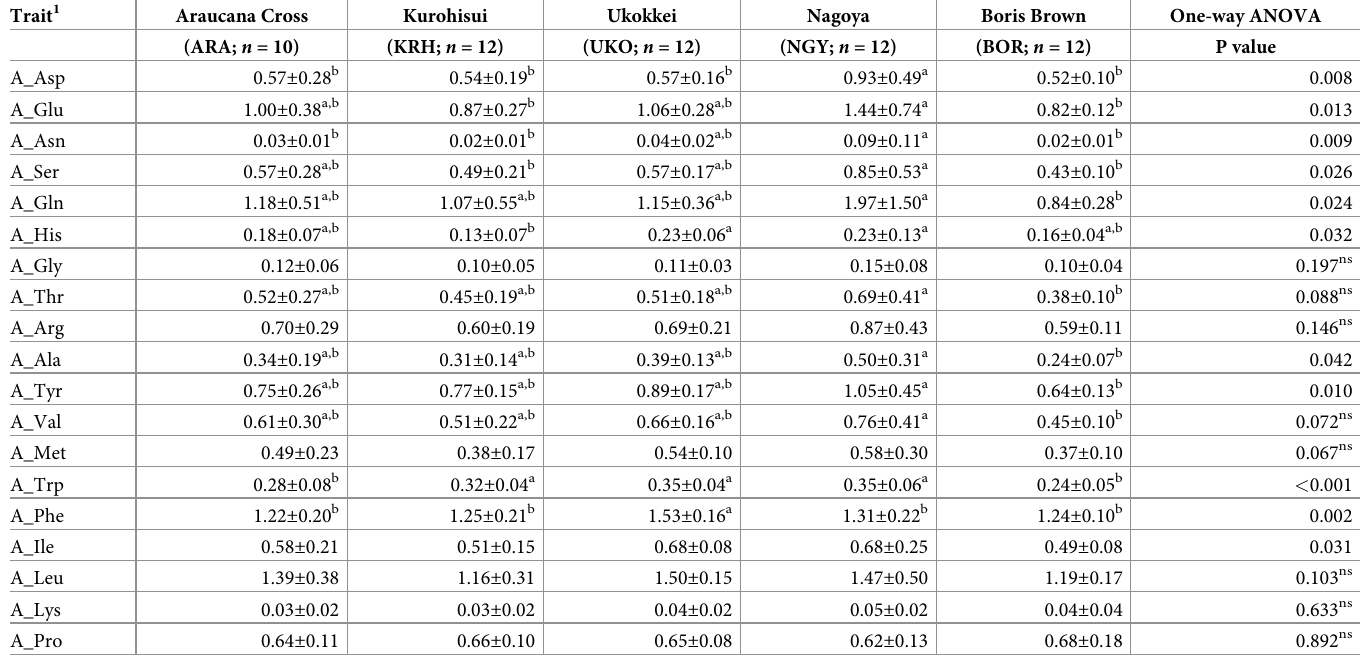
1 Trait abbreviations are shown in Materials and Methods. Amino acids concentrations are shown in μ g/mL. ns not significant (P > 0.05). a-d The same superscript letter are not significantly different among the genotypes at P > 0.05 in each trait (Tukey’;s HSD